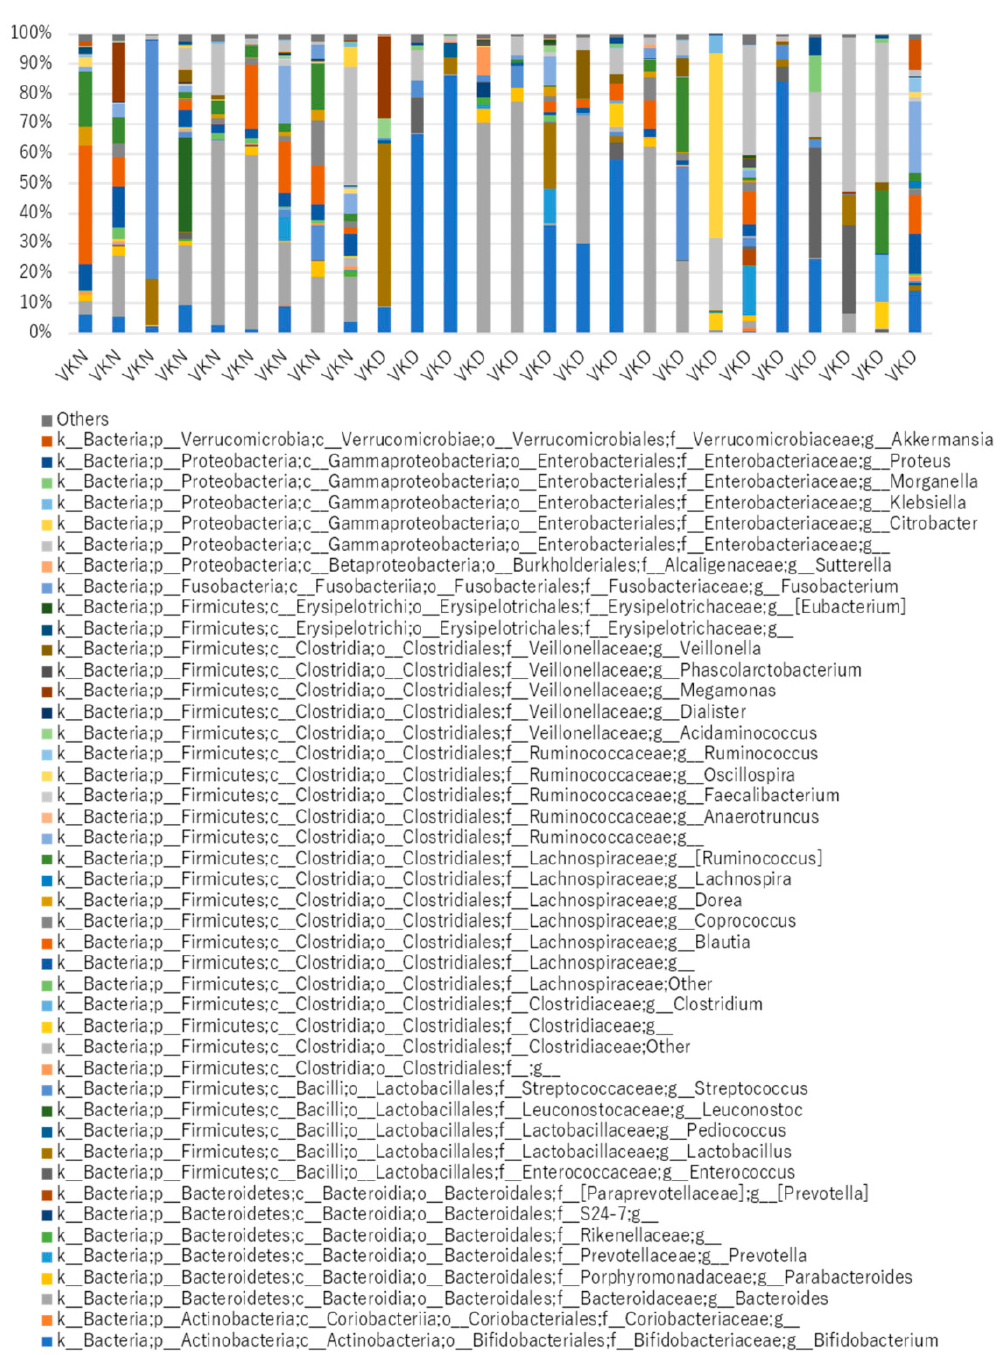
Figure 7. Gut microbiota at the genus level in 26 patients. VKN, vitamin K-normal group; VKD, vitamin K-deficient group; k_, kingdom; p_, phylum; c_, class; o_, order; f_, family; g_, genus.